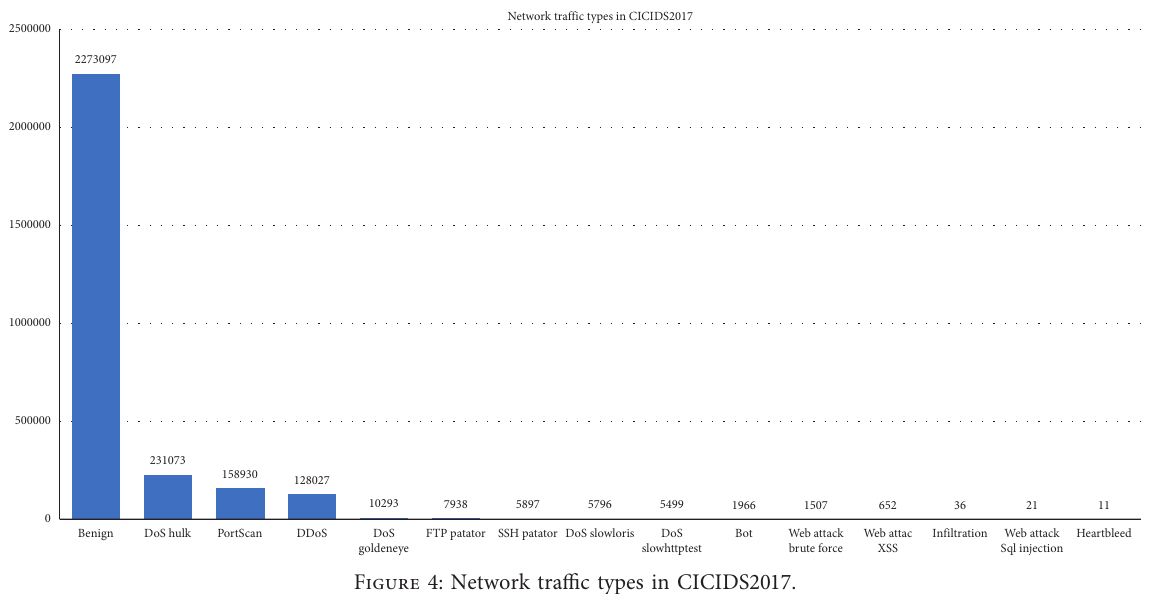
Figure 4: Network traffic types in CICIDS2017.